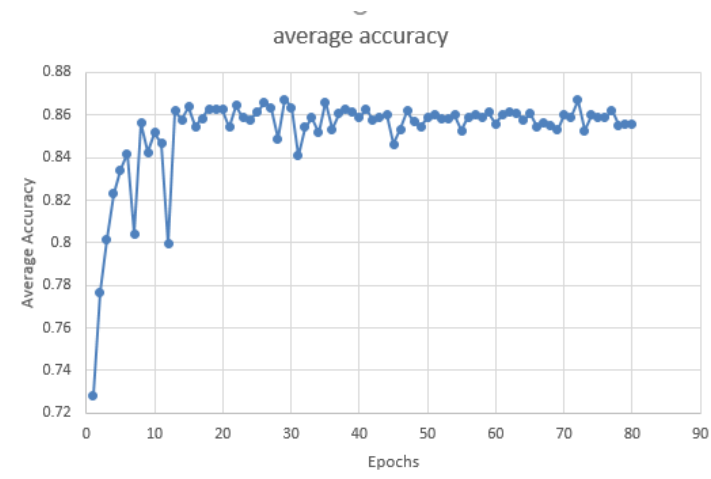
Figure 10. Evolution of average accuracy of BiseNet trained on